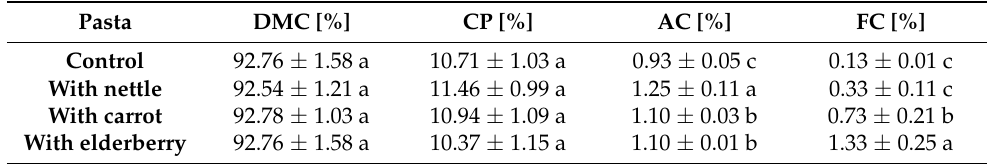
Table 1. Nutritional composition of prepared pasta.